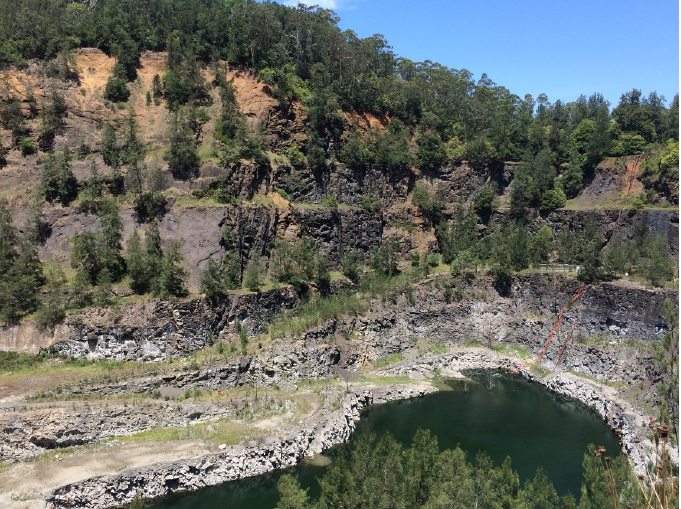
Figure 3. High-angle surge layers in the southern face of Hornsby Quarry: an important feature of diatremes at the macro- to mesoscale. Benches are up to 30 m in height.